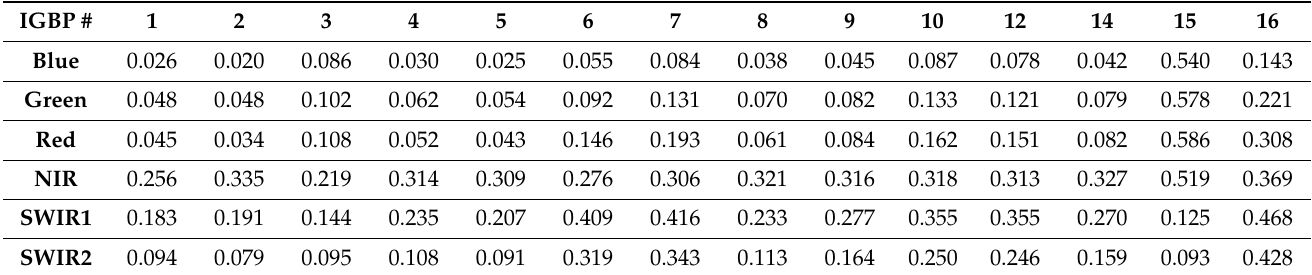
Table 2. Average banded reflected for each IGBP land cover type.